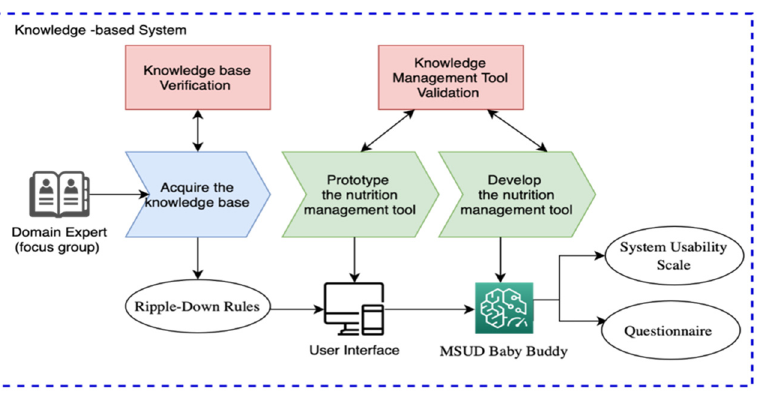
Figure 1. Flowchart to develop and evaluate knowledge base of MSUD Baby Buddy.